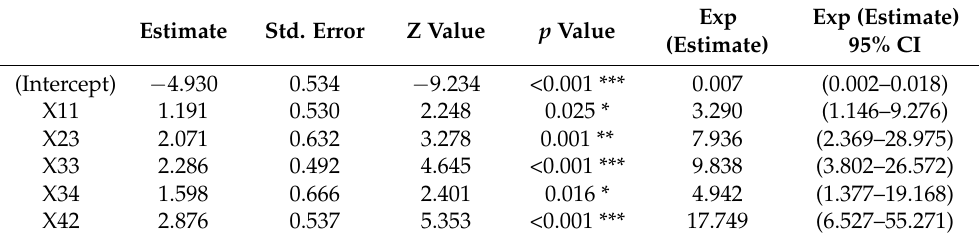
Table 4. Model of five independent variables.